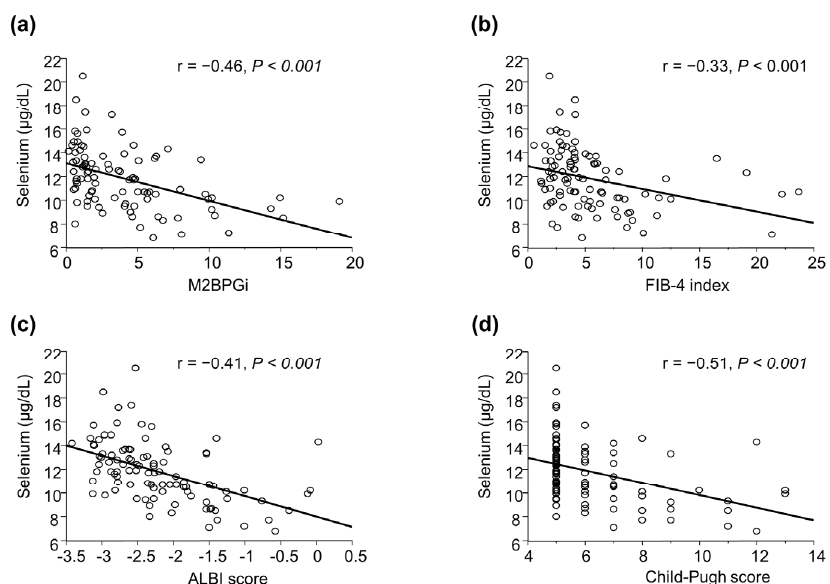
Figure 1. Correlation coefficients between serum selenium levels and ( a ) M2BPGi, ( b ) FIB-4 index, ( c ) ALBI score, and ( d ) Child–Pugh score in patients with chronic liver disease. The serum selenium levels were negatively correlated with M2BPGi (r = − 0.46, p < 0.001), FIB-4 index (r = − 0.33, p < 0.001), ALBI score (r = − 0.41, p < 0.001), and Child-Pugh score (r = − 0.51, p < 0.001). The data were analyzed using Spearman rank correlation coefficient. ALBI, albumin-bilirubin; M2BPGi, mac-2 binding protein glycan isomer. Table 2. Predictors associated with selenium deficiency in patients with chronic liver disease.